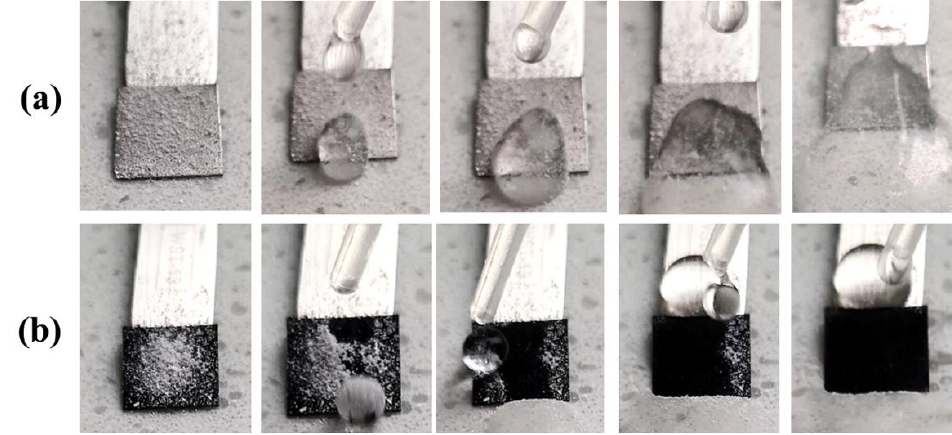
Figure 5. Self-cleaning test images for ( a ) ordinary iron and ( b ) SHI (FAS-13) samples.